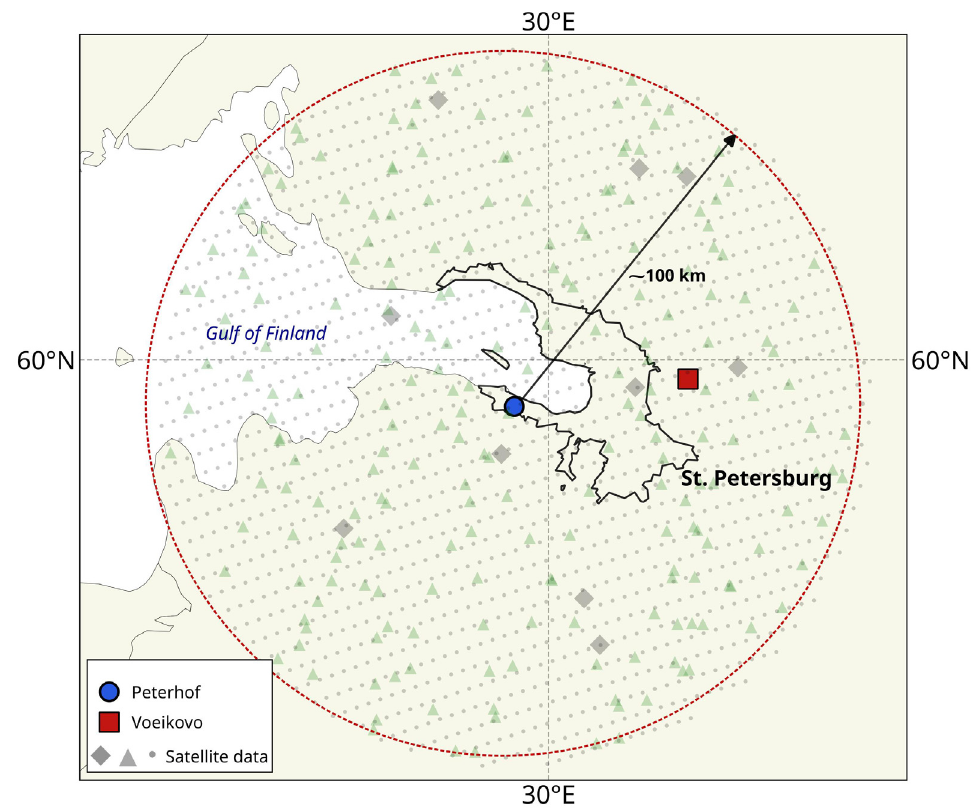
Figure 1. Positions of Peterhof and Voeikovo (ground-based observations) and spatial coverage by satellite data used near St. Petersburg (triangles, dots and diamonds depict OMI, TROPOMI and IKFS-2 daily observations, respectively).